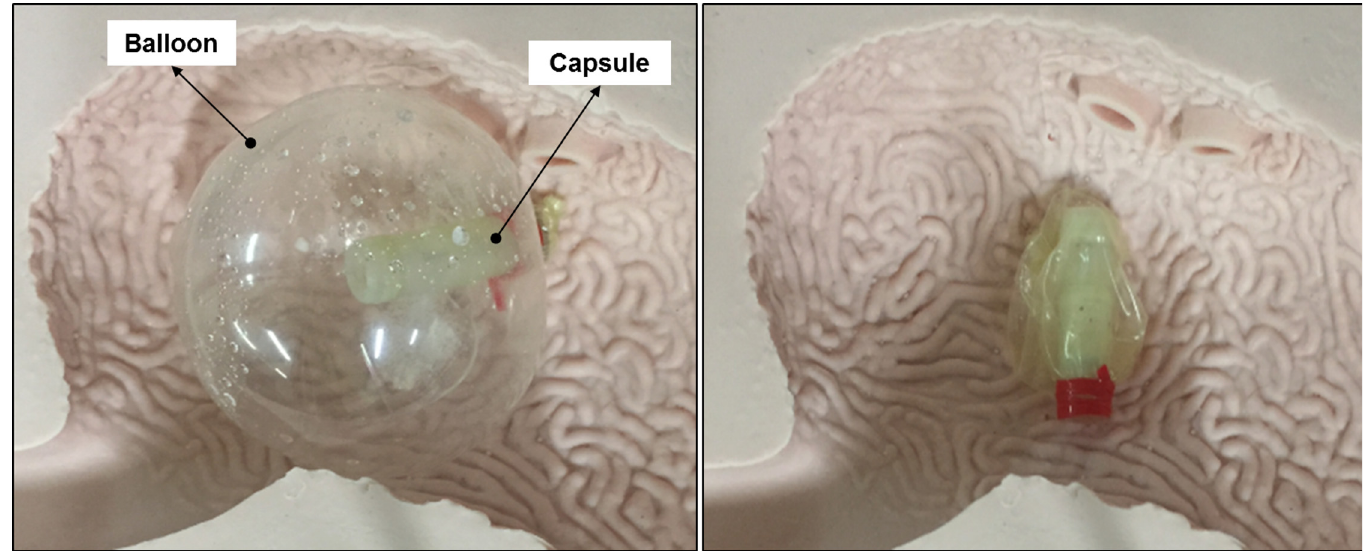
Fig 11. Validation results for the proposed MWCE on a virtual stomach EMS from The Chamberlain Group, USA. The left figure shows the balloon is inflated and the right shows the balloon is deflated to a compact